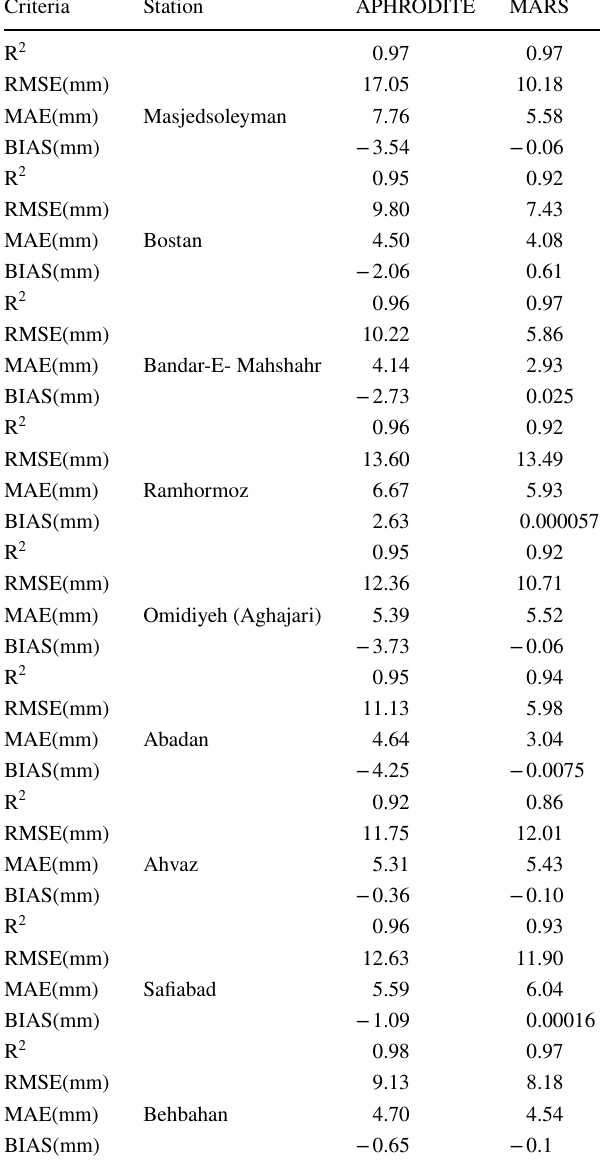
Table 5 The results combination of PCP outputs of five datasets by MARS method